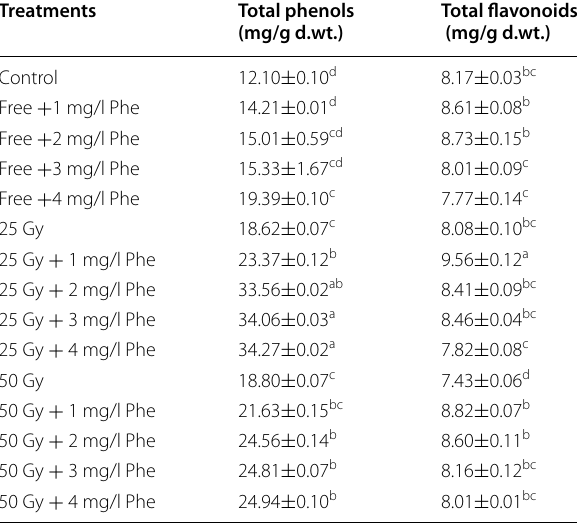
Different letters indicate a significant difference at P